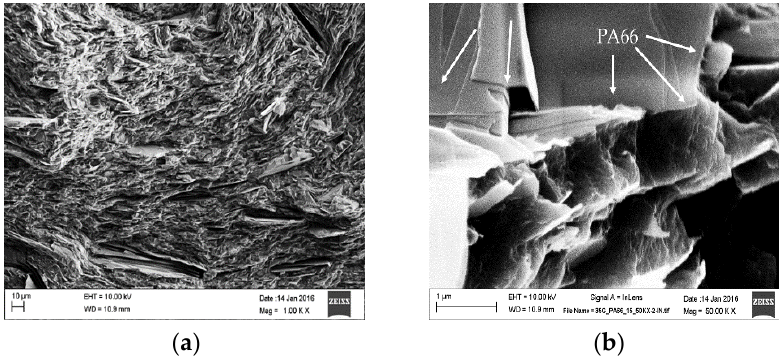
Figure 6. ( a ) Surface of cryogenically fractured G-PA66 20 min composite at low magnification; ( b ) Graphitic edge overhanging polymer in G-PA66 20 min composite.